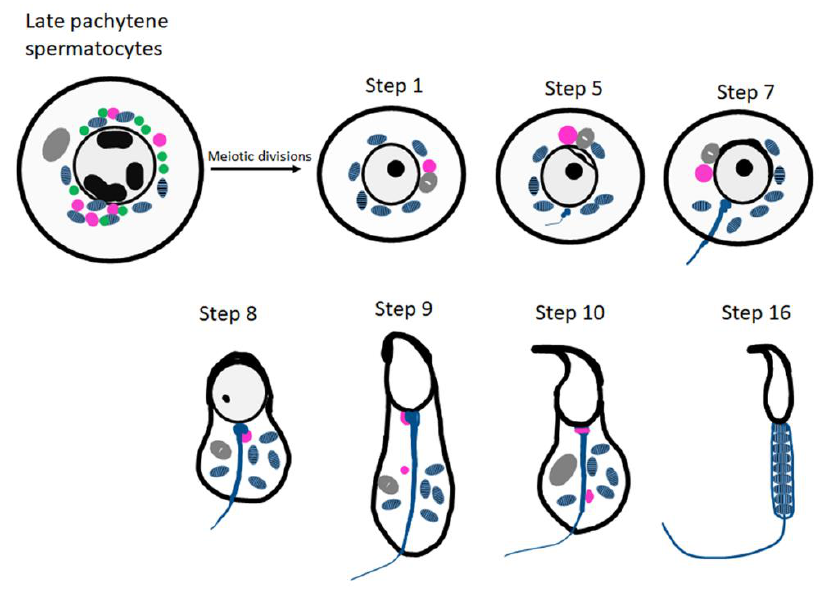
Figure 1. Schematic representation of CB organization and fate during spermiogenesis in mice. The inter-mitochondrial cement (IMC; green) intermixed with mitochondria (blue) and the CB precursors (pink) co-exist in late pachytene spermatocytes. The Golgi complex is depicted in gray. The CB (pink) is condensed to its final single form in the early round spermatids. At step 8 of spermiogenesis, the CB is found at the basis of the flagellum. Later, it splits into two separate structures (step 9 onwards) and eventually disappears.